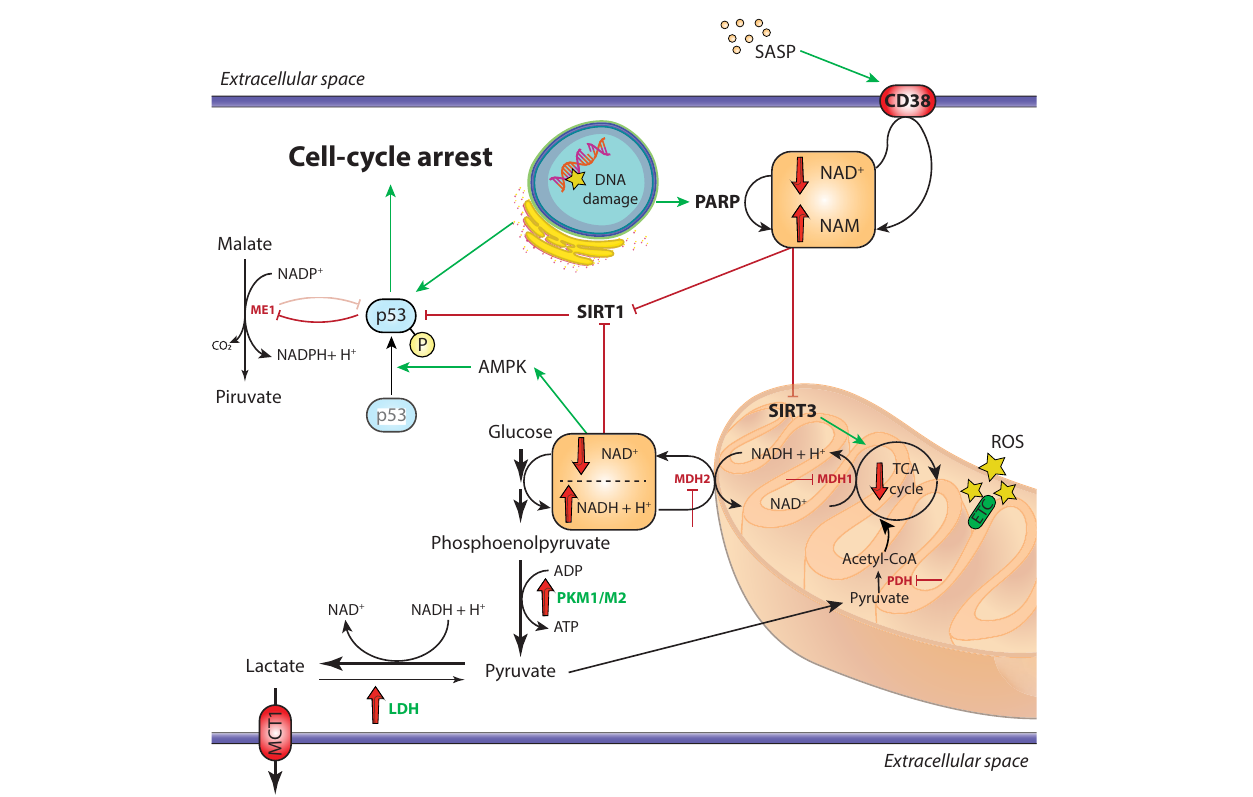
FIGURE 1 | Overview of the metabolic alterations driving cellular senescence. In cells undergoing replicative senescence, the upregulation of LDH and the inhibition of both PDH and the malate-aspartate shuttle (MDH1 and MDH2) result in the diversion of pyruvate away from oxidative phosphorylation and toward aerobic glycolysis. This leads to the decrease of cytosolic NAD + /NADH ratio, which triggers the activation of the energy sensor AMPK. Moreover, the accumulation of DNA damage, also mediated by ROS in the dysfunctional mitochondria and the SASP, activate the NAD + -consuming enzymes PARP1 and CD38, respectively. The subsequent impairment of SIRT1 deacetylase activity, coupled with the AMPK-mediated phosphorylation of p53, triggers the arrest of cell replication and the establishment of irreversible senescence. Moreover, activated p53 inhibits the activity of the malic enzymes ME1 and ME2, further impairing the cellular antioxidant mechanisms through reduction of NADPH levels. Downregulated enzymes are in red, upregulated enzymes are in green; red and green arrows indicate repression or induction, respectively. AMPK, adenosine monophosphate-activated protein kinase; ETC, electron transport chain; LDH, lactate dehydrogenase; MCT1, monocarboxylate transporter 1; MDH1/MDH2, malate dehydrogenase 1/2; ME1, malic enzyme 1; PARP, poly (ADP-ribose) polymerase; PDH, pyruvate dehydrogenase; PKM1/PKM2, pyruvate kinase M1/M2; ROS, reactive oxygen species; SASP, senescence-associated secretory phenotype; SIRT, sirtuin; TCA, tricarboxylic